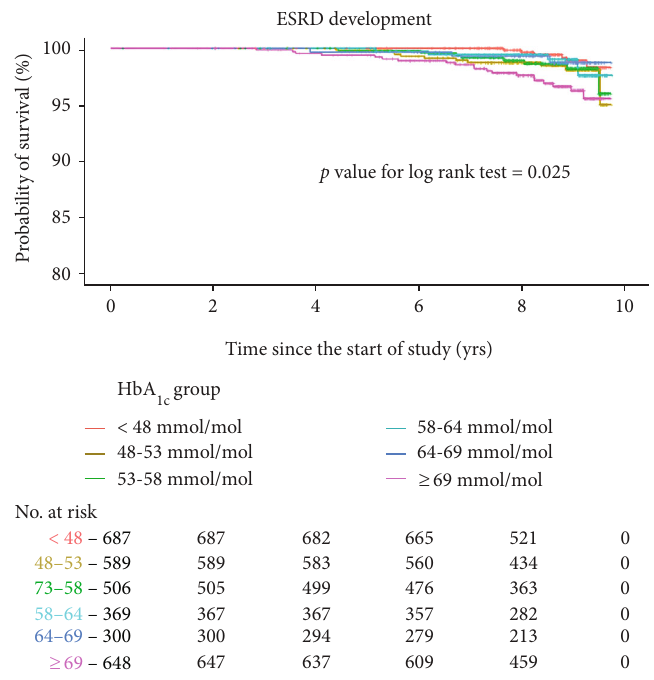
Figure 3: Kaplan-Meier curves for the development of end-stage renal disease according to baseline glycated hemoglobin. Abbreviations: HbA : glycated hemoglobin; ESRD: end-stage renal disease; No.: number. Kaplan-Meier curves strati fi ed by baseline HbA 1c groups. Renal outcome was de fi ned as the fi rst ESRD development in all subjects including CKD naïve ( n = 2357 ), normal GFR with albuminuria ( n = 330 ), and preexisting CKD ( n = 412